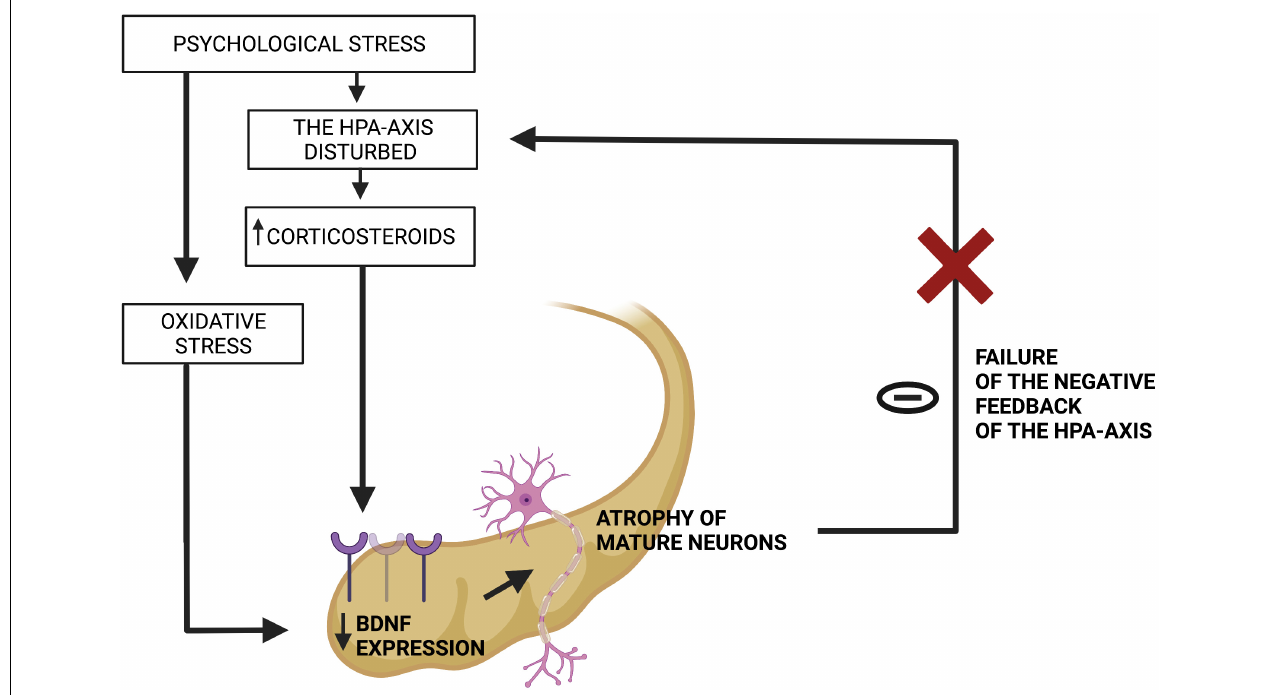
FIGURE 2 | Failure of the negative feedback loop between the hippocampus and the HPA-axis. Source: authors; created in BioRender.com. In genetically predisposed individuals, a hostile environment leads to psychological stress, which in its chronic form impairs the HPA-axis and triggers oxidative stress. They both decline BDNF expression in the hippocampus, which atrophies this organ and makes it unable to fulfill its function of suppressing the